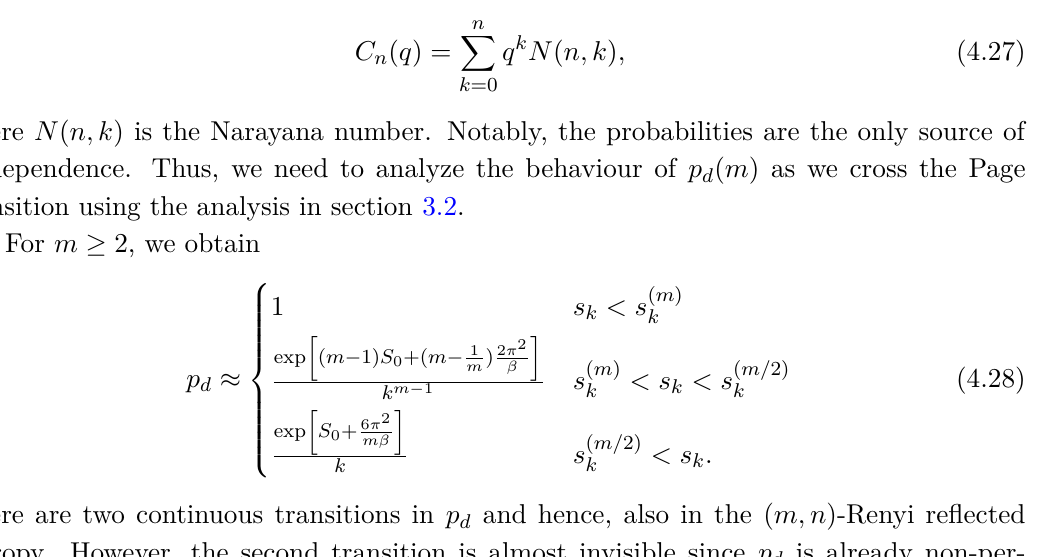
Figure 9 . (a) The canonical purification in the disconnected phase has radiation systems purifying themselves. (b) The canonical purification in the connected phase has a state of radiation systems entangled via a closed universe. The two candidate RT surfaces are denoted orange and pink. where r = k 2 /k 2 and C ( q ) is the q -Catalan number defined n 1 2